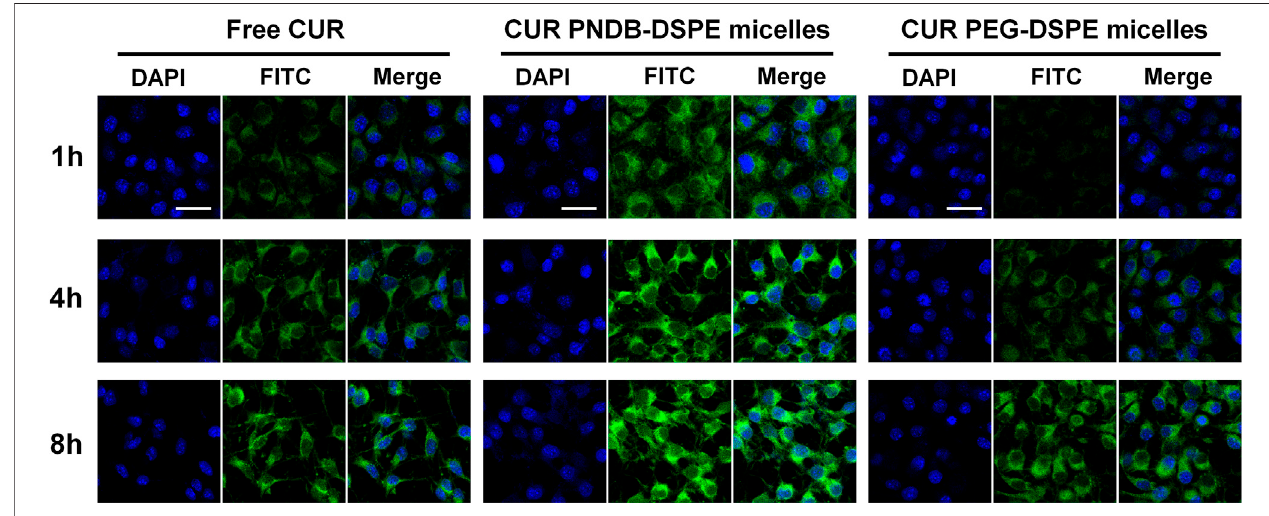
FIGURE 6 | Confocal images of B16F10 cells incubated with free CUR, CUR-PEG-DSPE micelles, and CUR-PNDB-DSPE micelles for 1, 4, and 8 h at an equal CUR concentration of 20 μ g mL − 1 ; bars indicate 25 μ m.